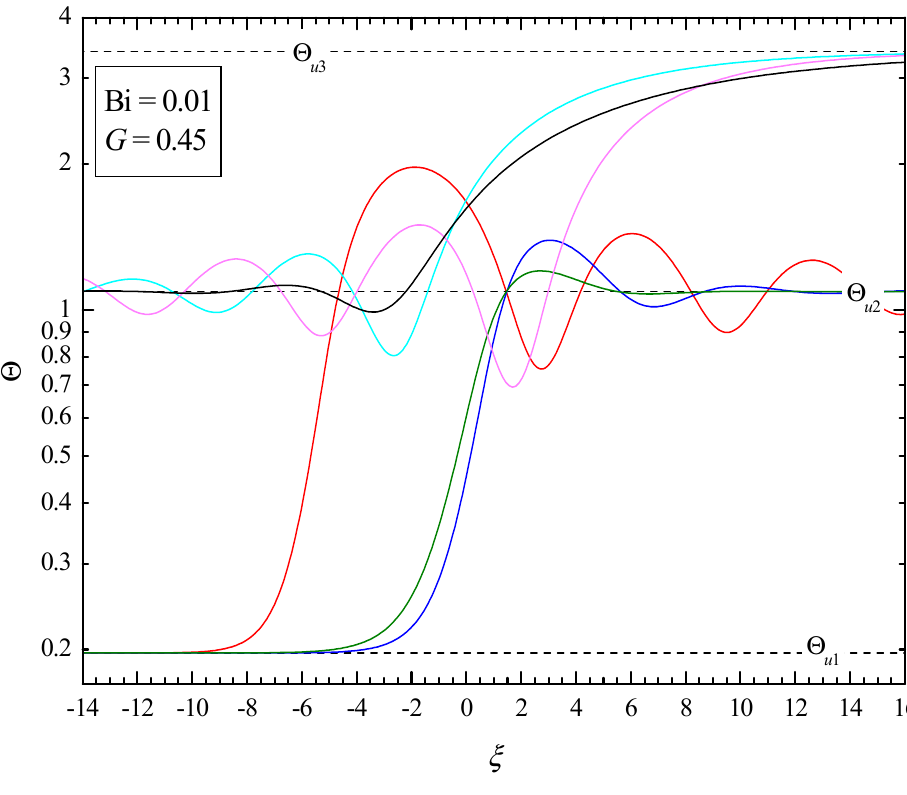
Figure 13. Oscillating wave fronts.